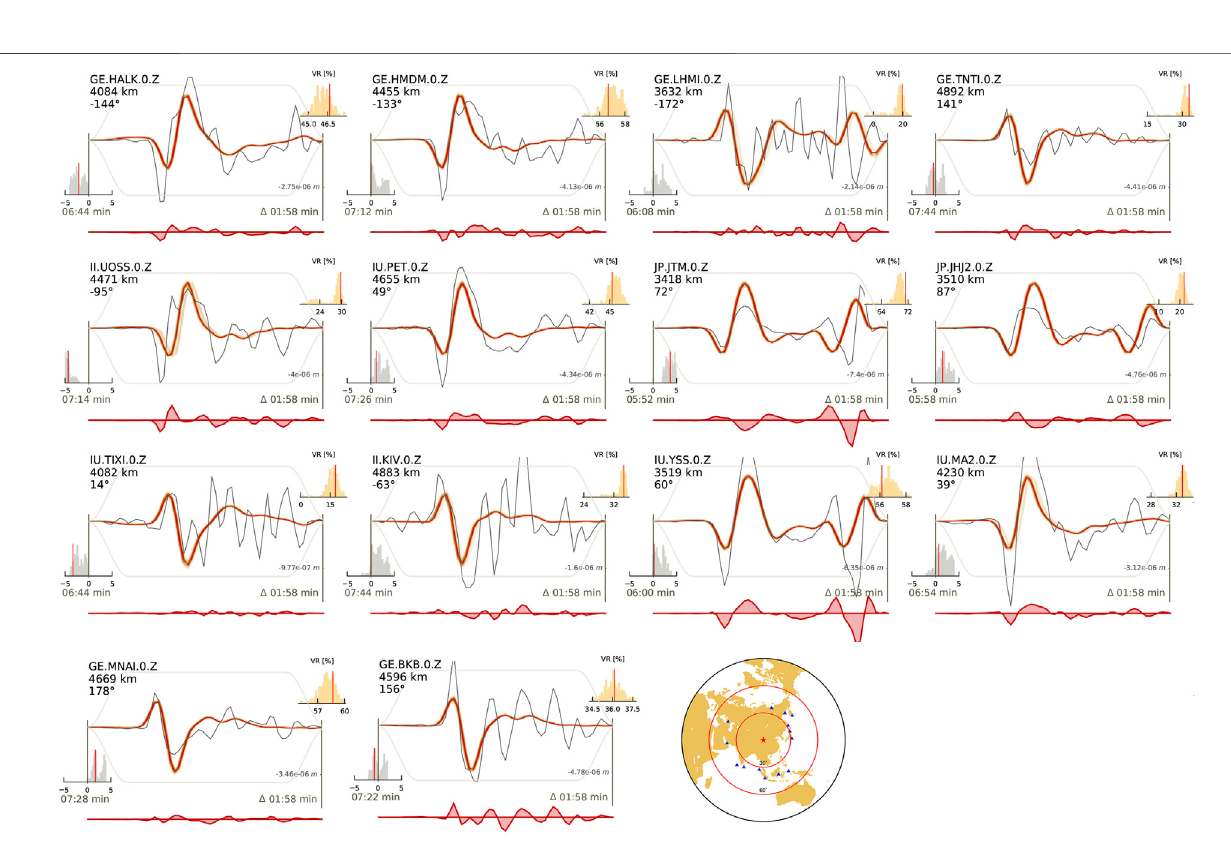
LHSR and along the long axis of the deformation fi eld, respectively. Figure 3 illustrates prominent centers of subsidence and uplift in both deformation pro fi les. Figure 3A indicates that the maximum deformation of the A1-A2 section in the ascending and descending images are 38 cm and 36 cm. And